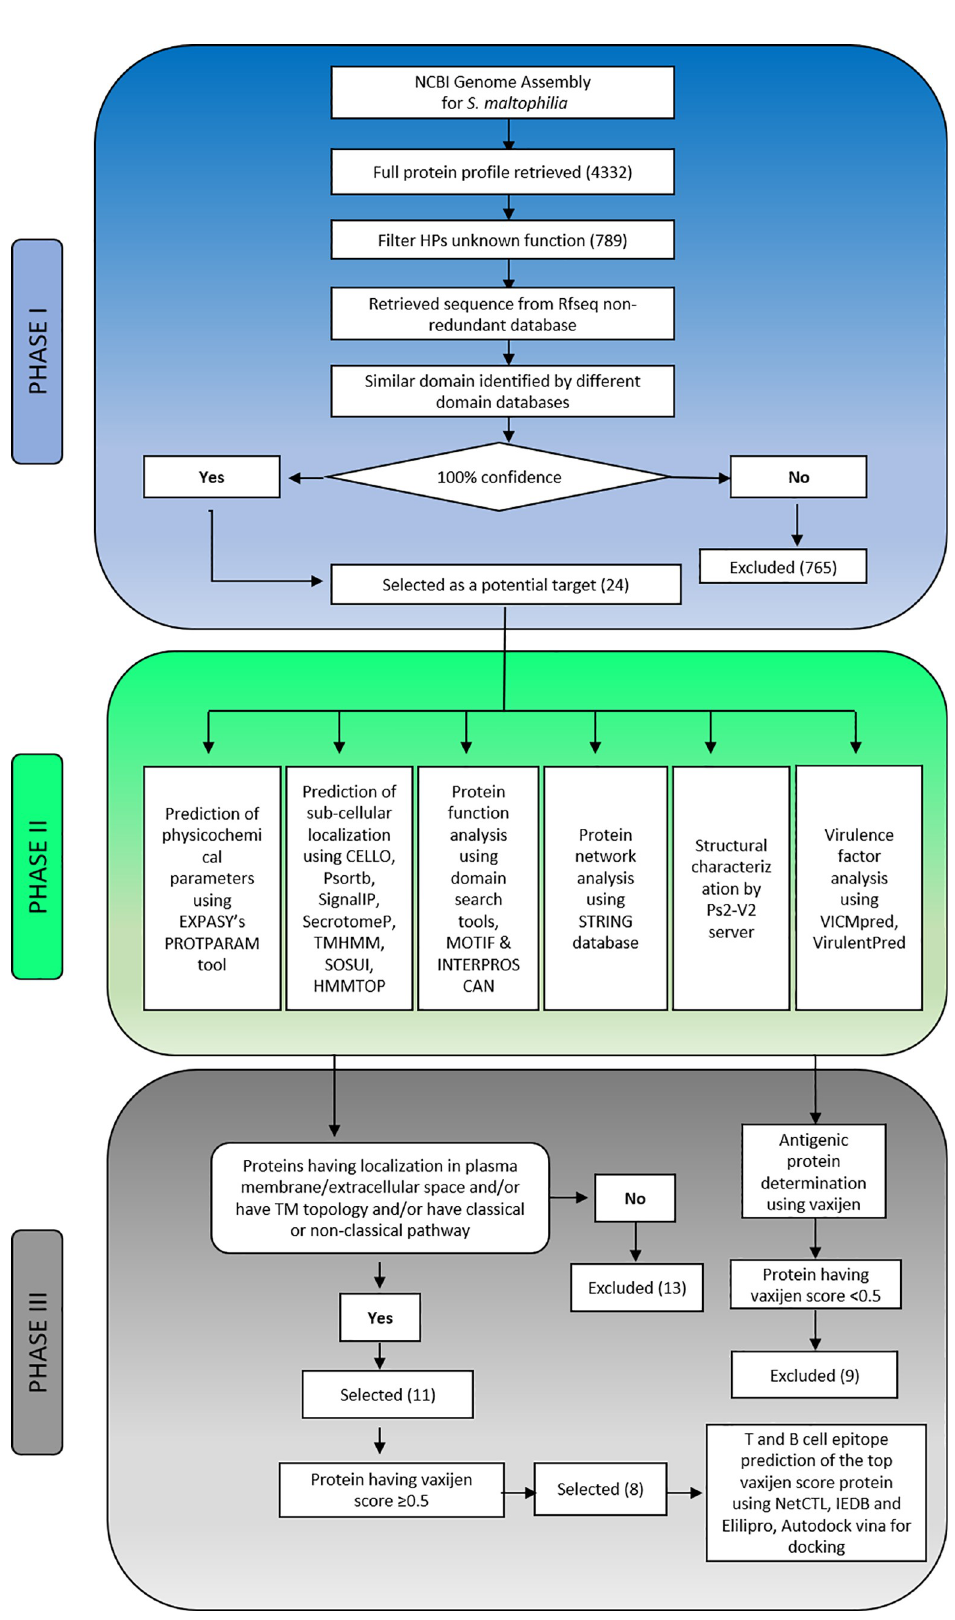
Fig 1. The complete framework of the study was used to annotate the functions of the 24 HPs from S. maltophilia . https://doi.org/10.1371/journal.pone.0252295.g001 PLOS ONE | https://doi.org/10.1371/journal.pone.0252295 May 27,